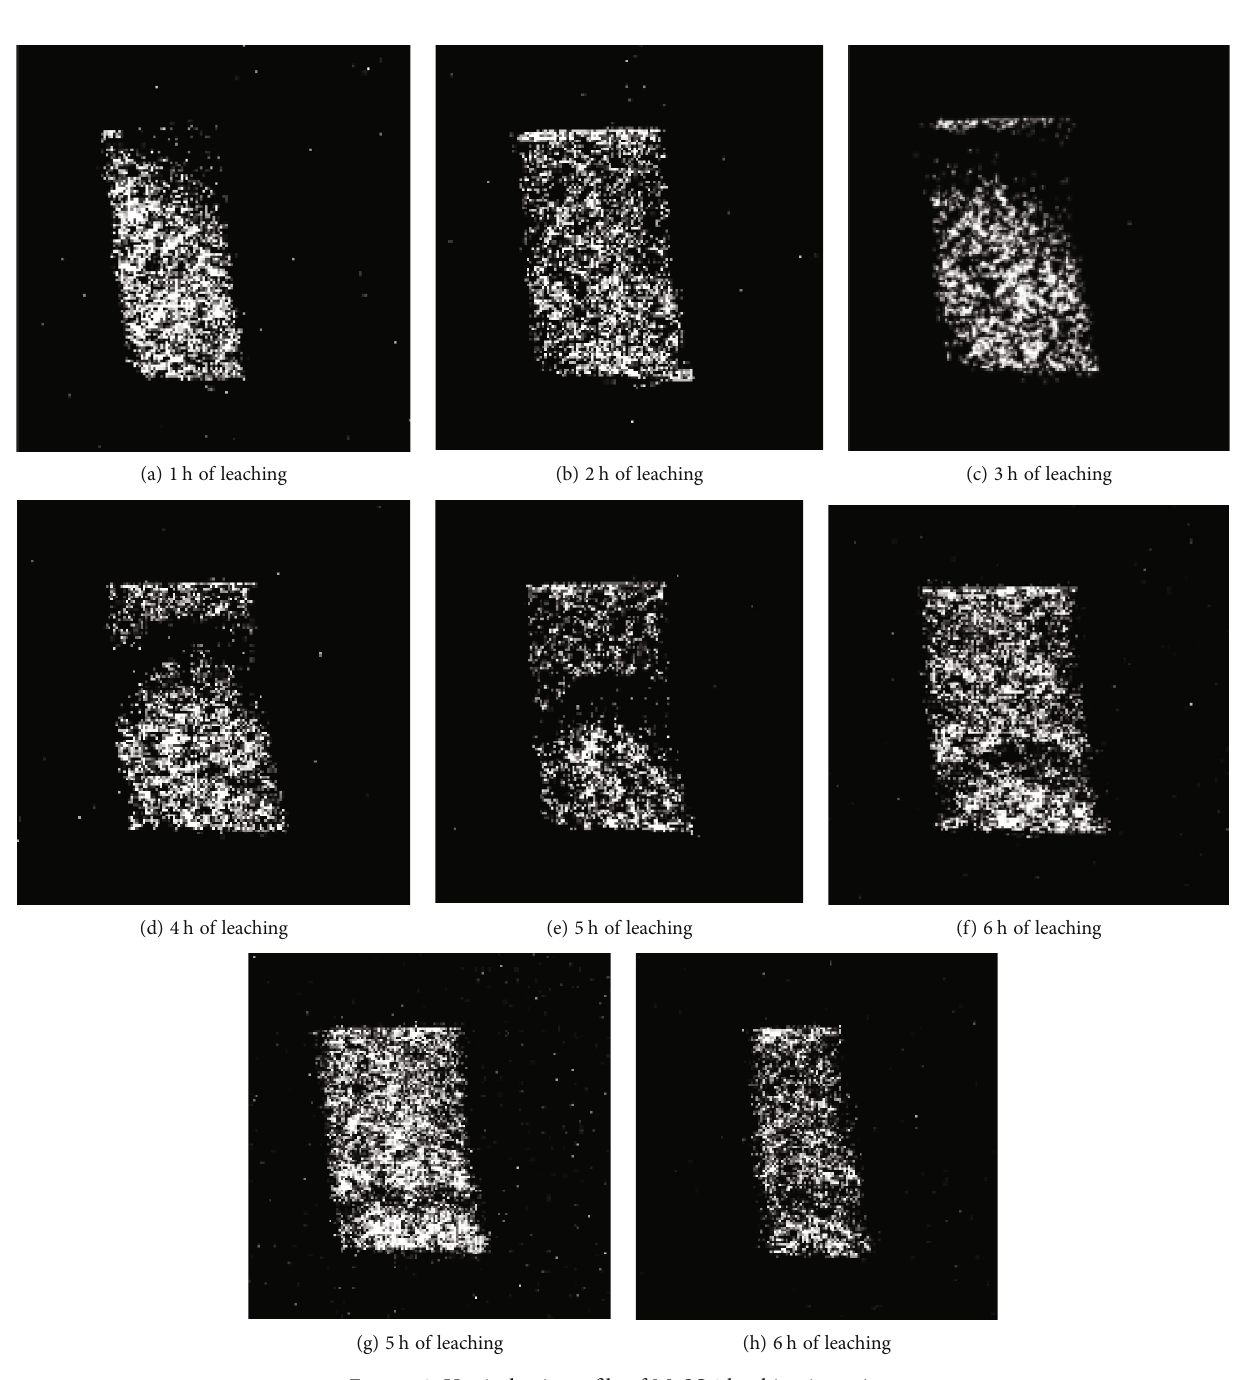
Figure 9: Vertical axis pro fi le of MgSO4 leaching